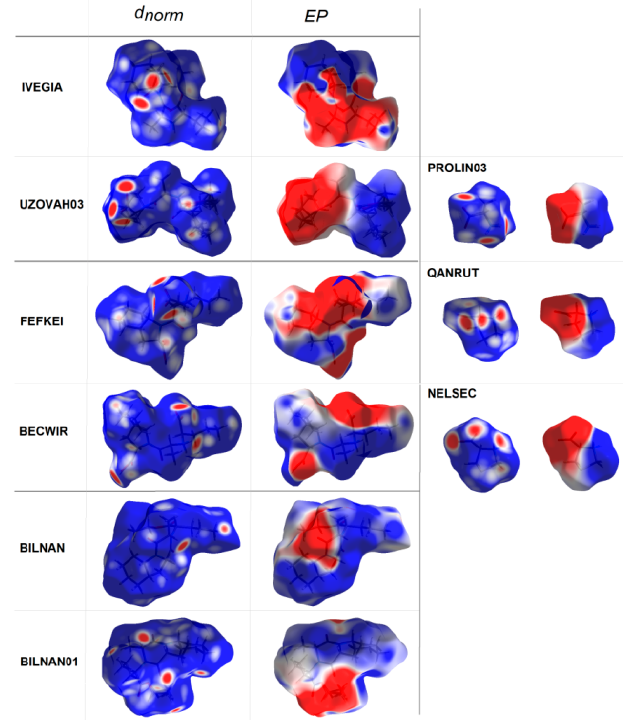
Figure 8. Views of the HSs mapped with d norm and EPs for perindopril-derived (on the left) and proline compounds (on the right).